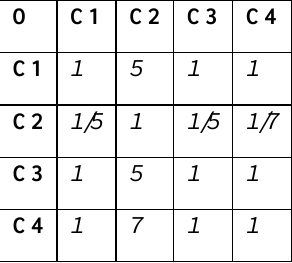
Table 4.2 Matrix M1: comparison of criteria by the ratio of preference with respect to the general objective